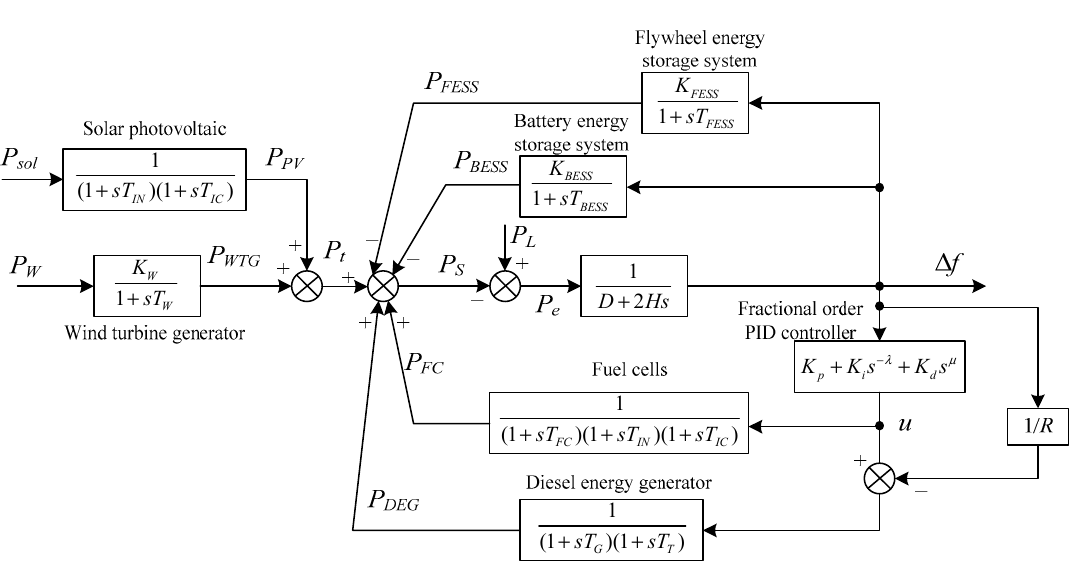
Figure 2. Block diagram of an islanded microgrid with small-signal models.